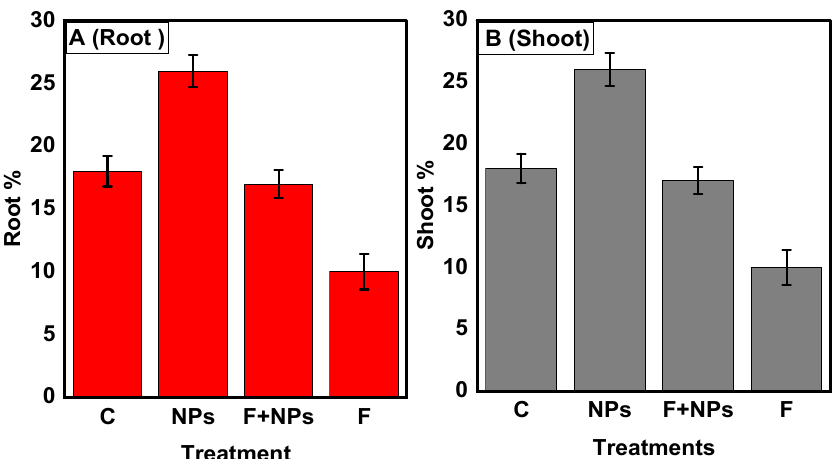
Figure 14. Root length ( A ) and shoot length ( B ) of chickpea under different growth conditions. C =